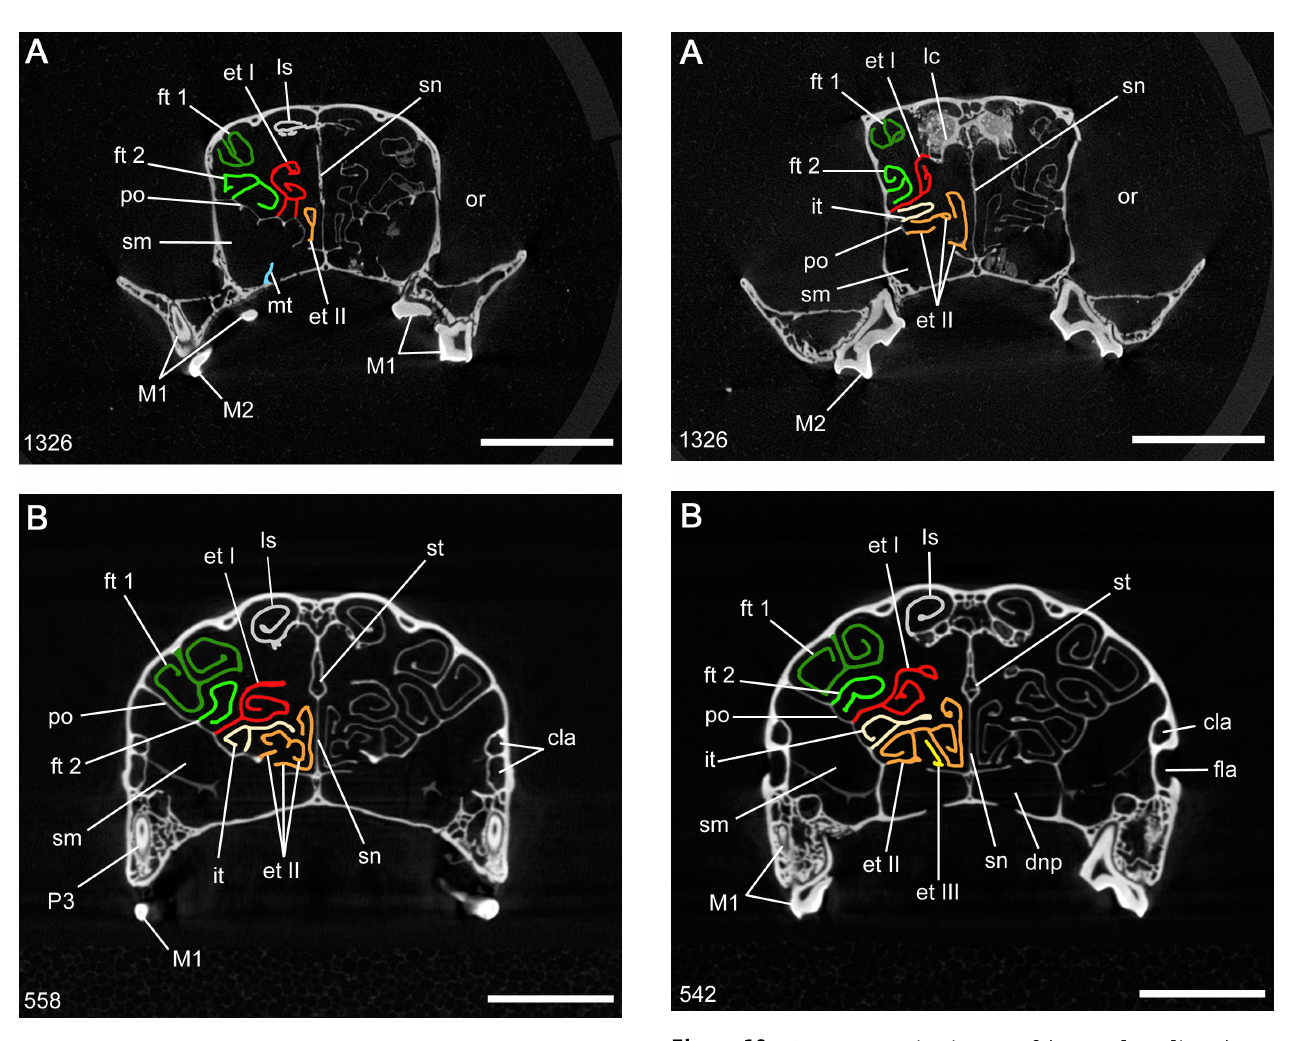
Figure 9. µCT cross-section images of the pars lateralis and pos- terior of the adult rostrum from anterior to posterior of (a) Ptilo- cercus lowii (ZMB 3992) and (b) Tupaia sp. (collection W. Maier). Numbers in figures refer to number of original µCT slices. Abbrevi- ations: cla, canaliculus lacrimalis; et I, II, ethmoturbinal I, II; ft 1, 2, frontoturbinal 1, 2; it, interturbinal; ls, lamina semicircularis; M1, 2, upper molar 1, 2; mt, maxilloturbinal; or, orbit; P3, upper premo- lar 3; po, pars obtecta (paries conchalis); sm, sinus maxillaris; sn, septum nasi; st, septoturbinal. Scale bars equal 2mm.